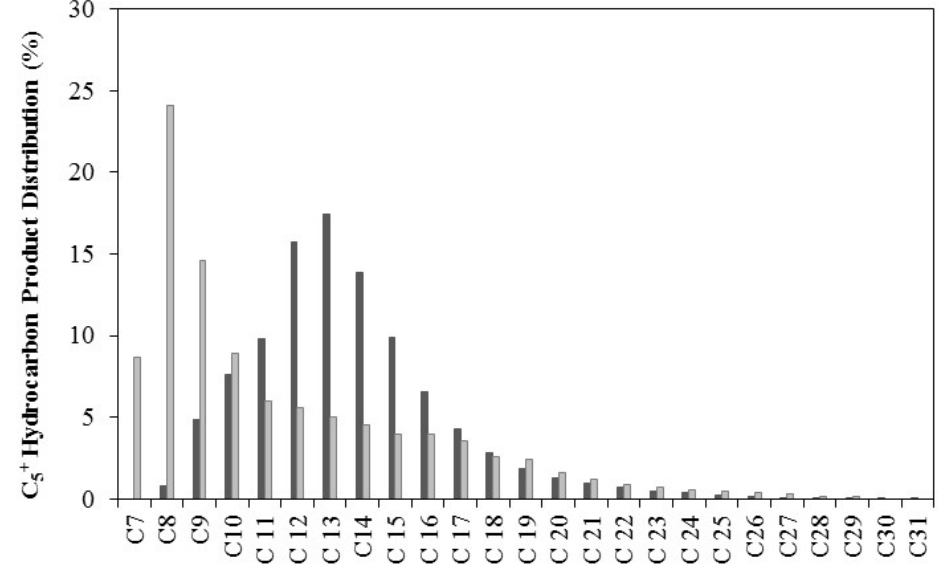
Figure 8. C 5+ hydrocarbon product distribution: CoCit/SiC; and CoN/SiC. Reaction conditions: 20 bar; 250 °C; 6000 Ncm 3 /g ∙ h; H 2 /CO: 2.